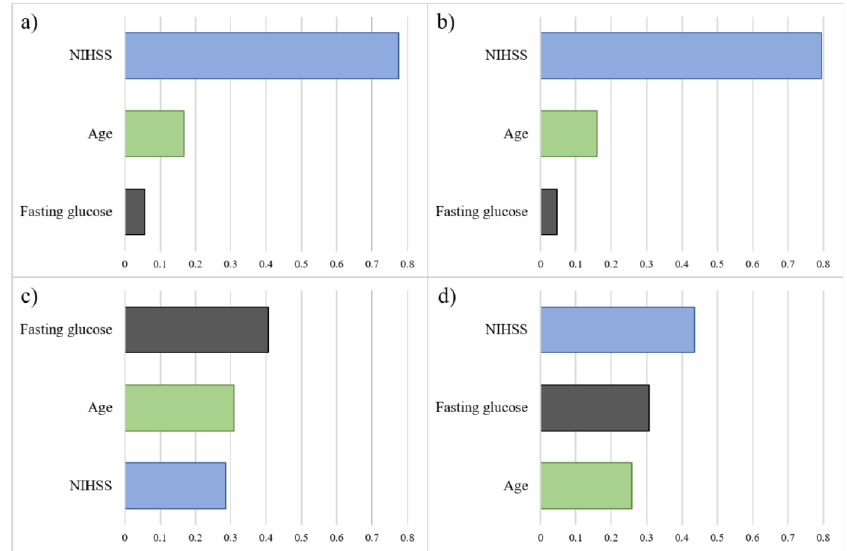
Figure 3. The importance and the ranking of the predictors based on Gain in XGBoost. Following the increasing accuracy of the branches, the longer horizontal bar represents greater importance attributed to the model. (a) Entire cohort. (b) Non-thrombolytic. (c) EVT. (d) IVT.